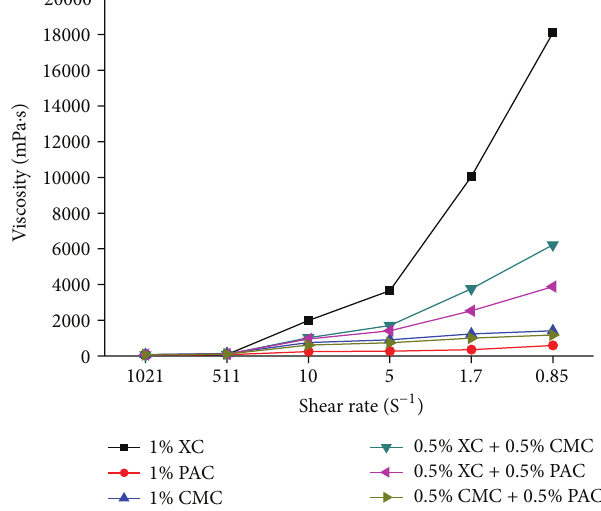
Figure 2: The apparent viscosity under different shear